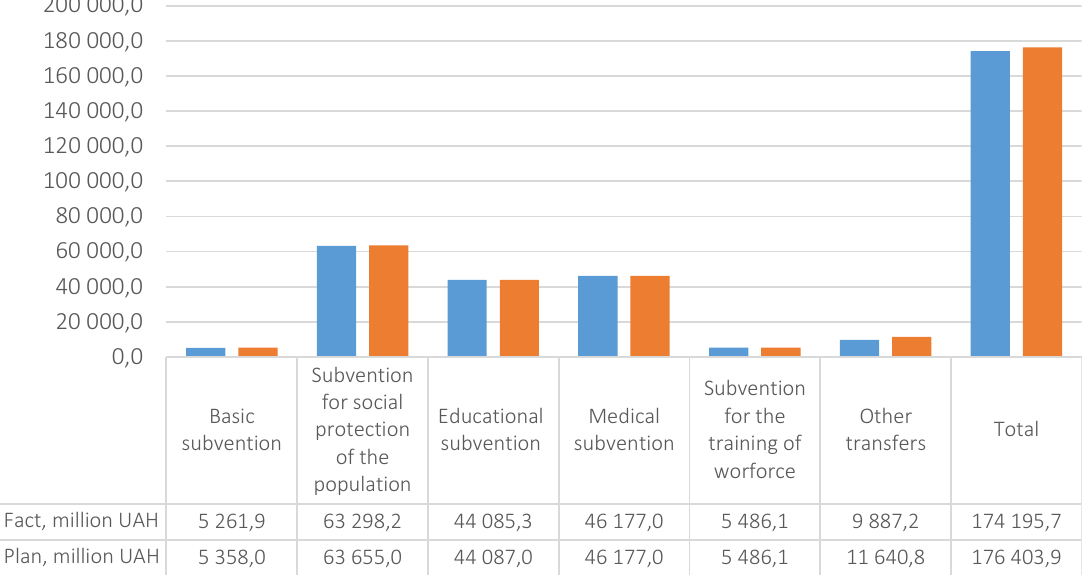
Figure 3. The structure of inter-budgetary transfers in 2015